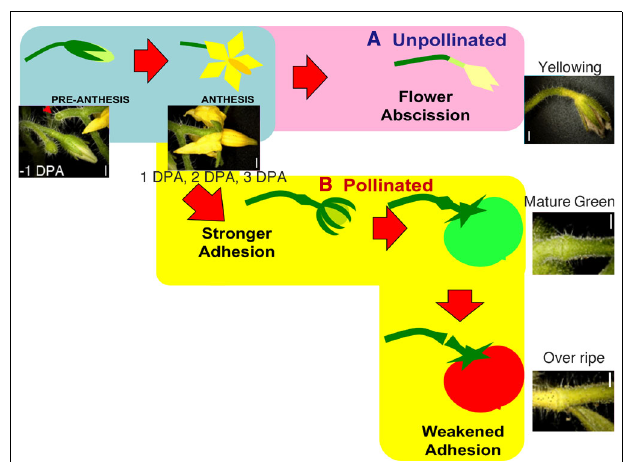
FIGURE 1 | Schematic diagram of the regulation of flower and fruit adhesion in tomato AZs. Once the flowers are successfully pollinated and fruits start to develop, the AZs enlarge and adhesion becomes stronger until the fruits fully ripen (B) . Unsuccessful pollination leads to flower detachment from the AZ (A) . Red arrowheads indicate pedicels separated at AZ. Bars = 1 mm. Adapted from Iwai et al. (2013).